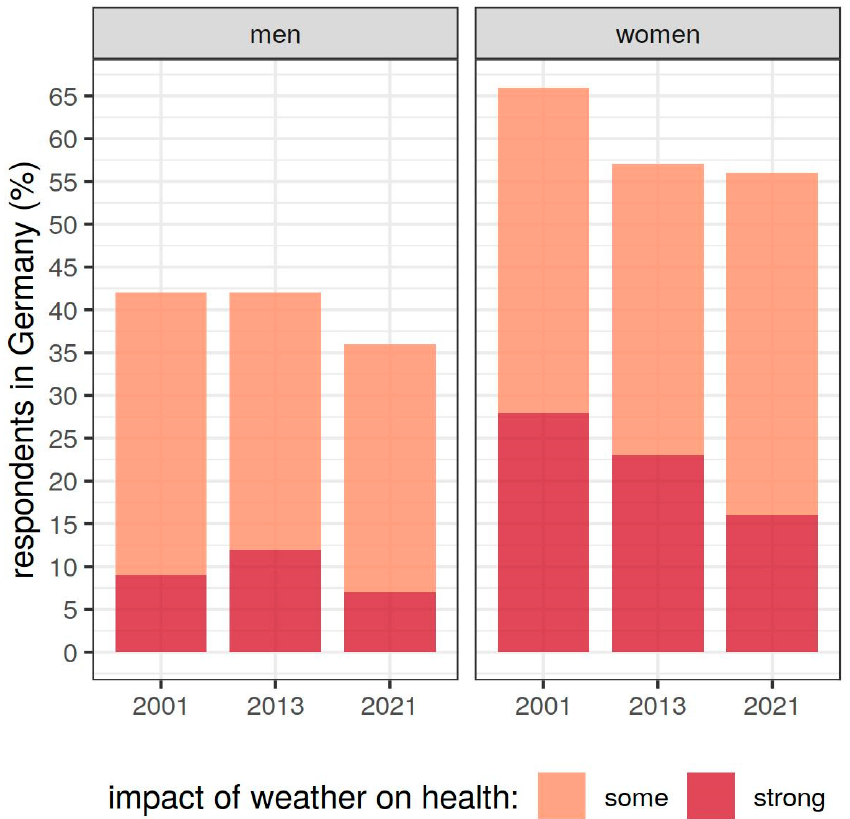
Figure 2. Development of weather sensitivity among men and women. The data are based on representative surveys conducted by IfD Allensbach (self-assessment by respondents).